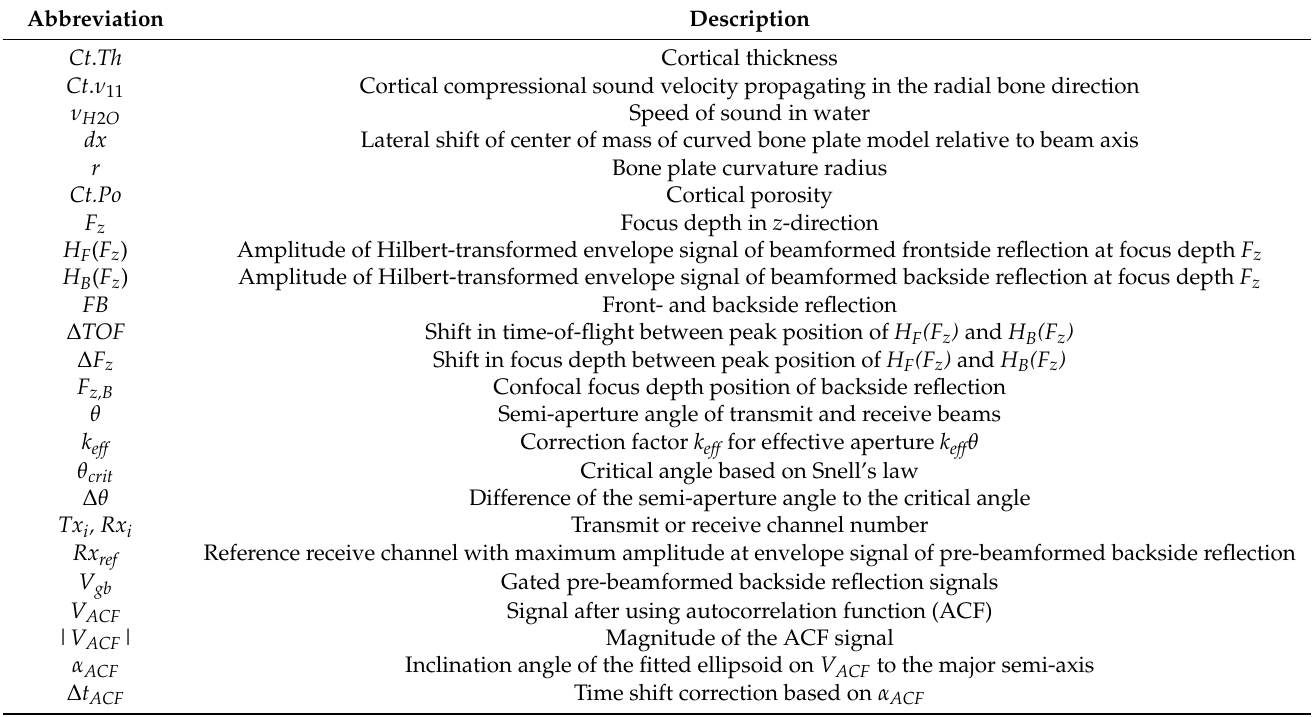
Table 1. List of